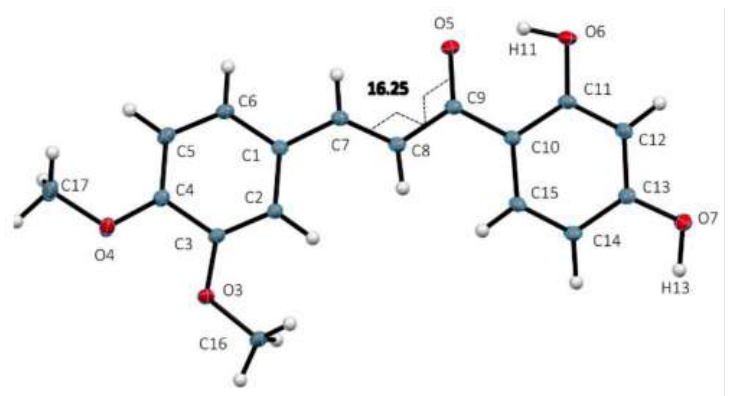
Figure 2. The 3D molecular structure of 2 (cid:48) ,4 (cid:48) -dihydroxy-3,4-dimethoxychalcone ( 2 , DHDM). Largest torsion angle C7-C8-C9-O5 is 16.3(2) ◦ . Anisotropic displacement parameter ellipsoids are drawn at 50% probability.